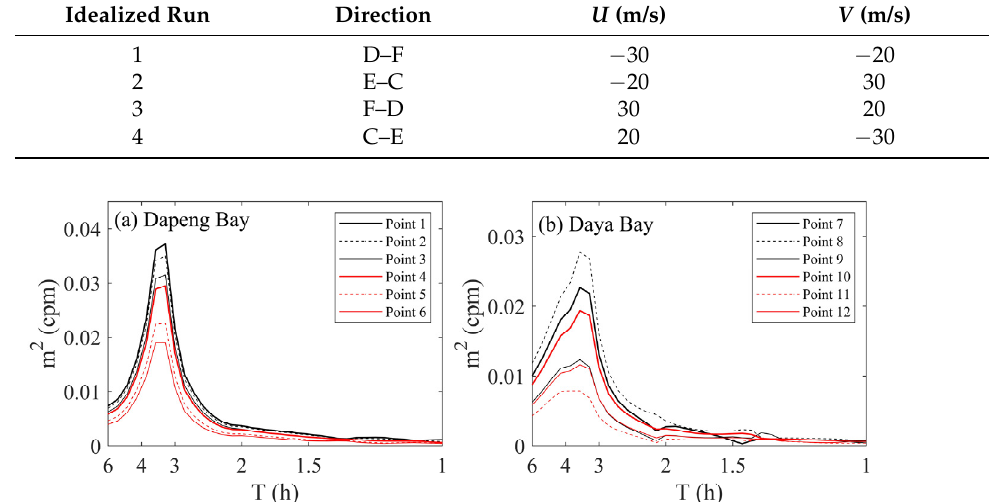
Figure 10. Power spectra of sea levels at ( a ) six locations in Dapeng Bay and ( b ) six locations in Daya Bay based on results produced by the inner sub-model with the direction of constant wind forcing in the E–C direction.